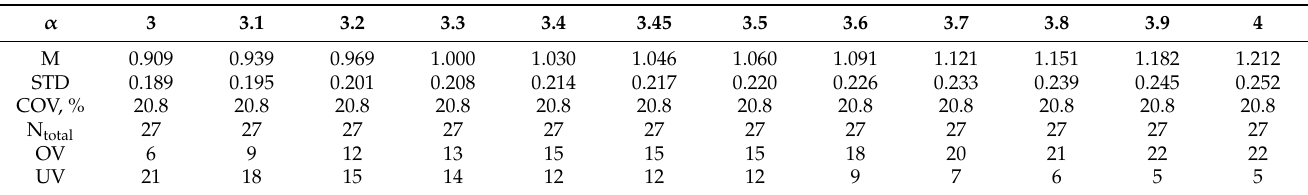
Table A5. The influence of α on the statistical results of L t.teor /L t.exp of CFCC strands.